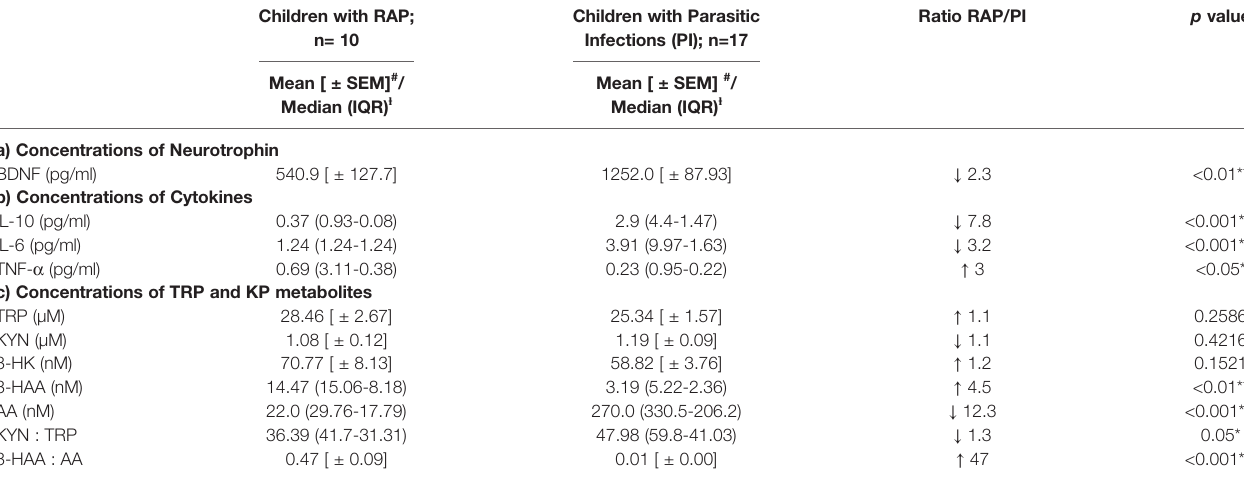
TABLE 2 | The BDNF, cytokines and kynurenine pro fi les in children with RAP and children with subclinical parasitic infections. Children with RAP; Children with Parasitic n= 10 Infections (PI);